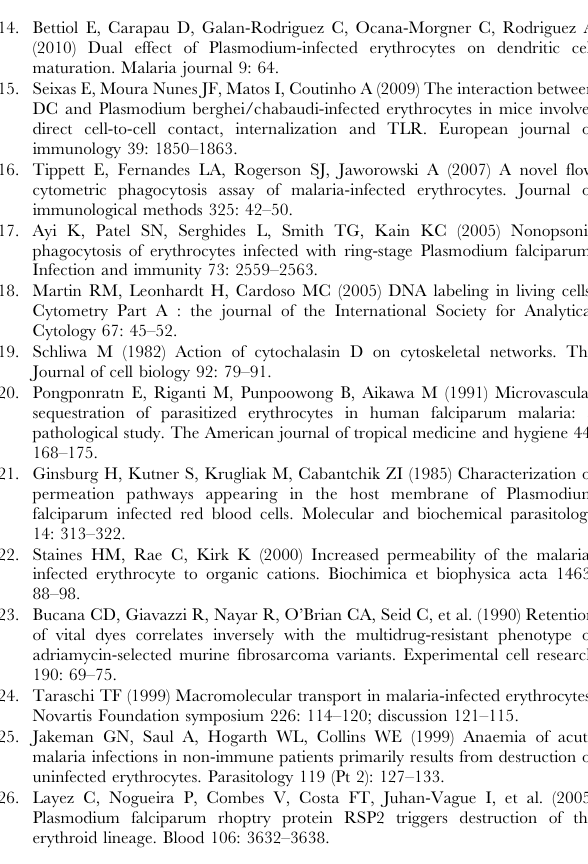
Figure S1 Giemsa stain of ring-staged 3D7 Plasmodium falciparum cultures with a parasitemia of about 15%. (TIF) Figure S2 Expression of surface markers on THP-1 cells before and after PMA differentiation. THP-1 monocytes (solid black line) and THP-1 macrophages differentiated with 10 ng/ml PMA (solid gray line) were incubated with A ) APC-Cy7 antihuman CD36 and B ) PE antihuman CD68 for 30 min at 4 u C. The differentiated macrophages showed an up-regulation of CD36 and CD68 compared to the monocytes. (TIF) Figure S3 Forward and side scatter plot of 3D7 Plasmodium falciparum cultures with the R18 gating used to analyze the erythrocyte population for deter- mining optimal DHE concentration.